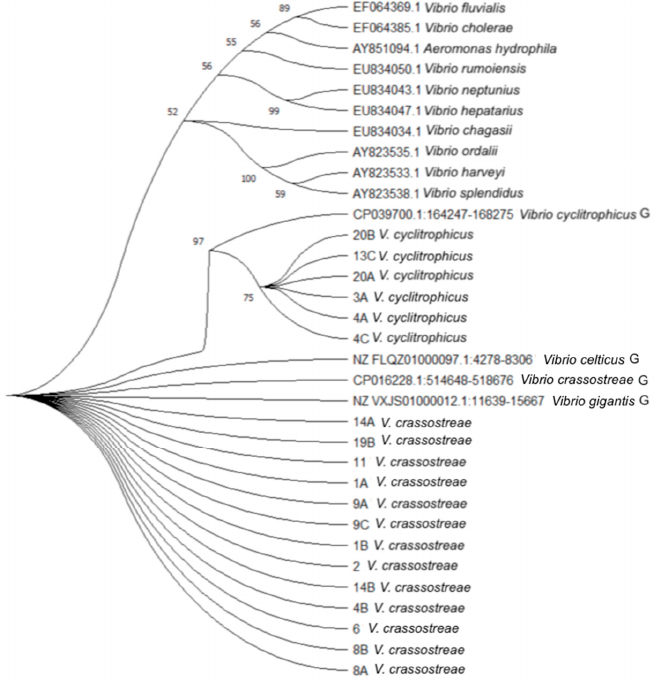
Figure 3. Phylogenetic relationship among Vibrio species isolated from lesser-spotted dogfish and different Vibrio species. Phylogenetic tree was constructed using MEGAX and neighbor-joining method. A bootstrap test of 1000 replicates was performed; the bootstrap condensed tree, using a cut-off value of 50% is shown. The sequences with “G” displayed after the scientific name derived from a deposited